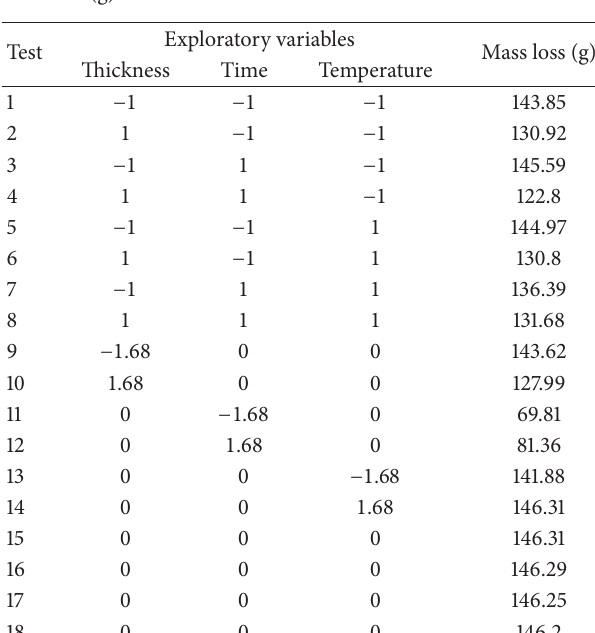
Table 8: Box-Behnken design with observed response for tomato mass loss (g).